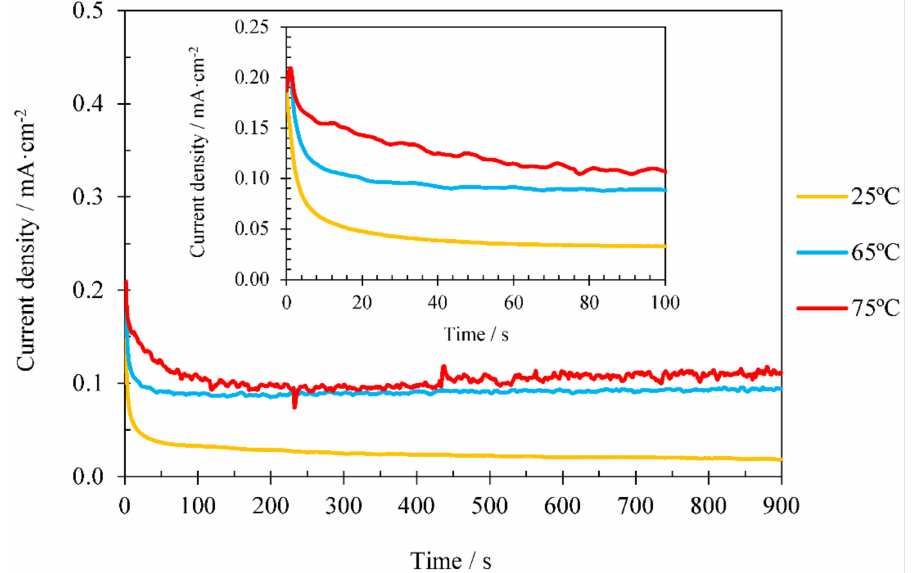
Figure 4. Effect of the electrodeposition temperature for TiO 2 /ZnO hybrid nanosponges during the electrodeposition process with 1 mM Zn(NO 3 ) 2 for 15 min on crystalline TiO 2 , with an insert of the first 100